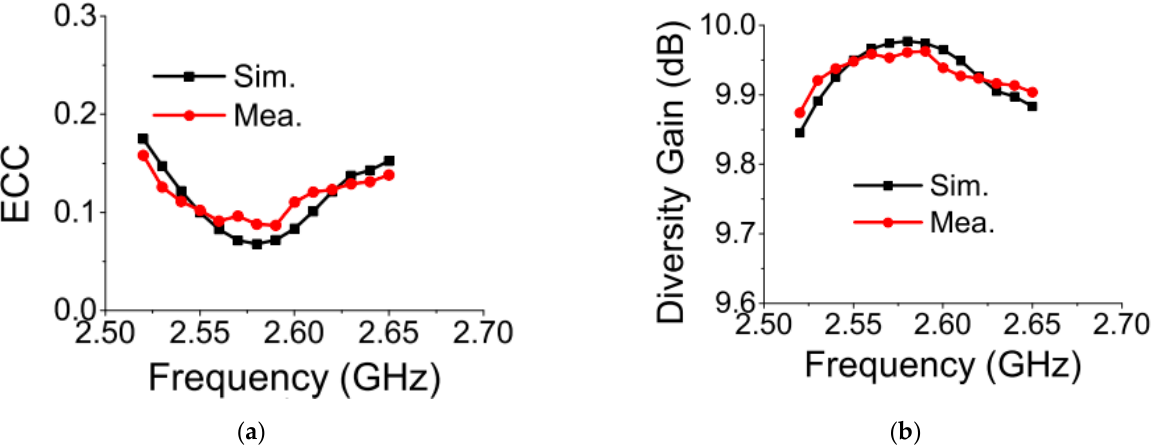
Figure 18. Diversity parameters of proposed MIMO antenna: ( a ) envelope correlation coefficient (ECC); ( b ) diversity gain (DG).